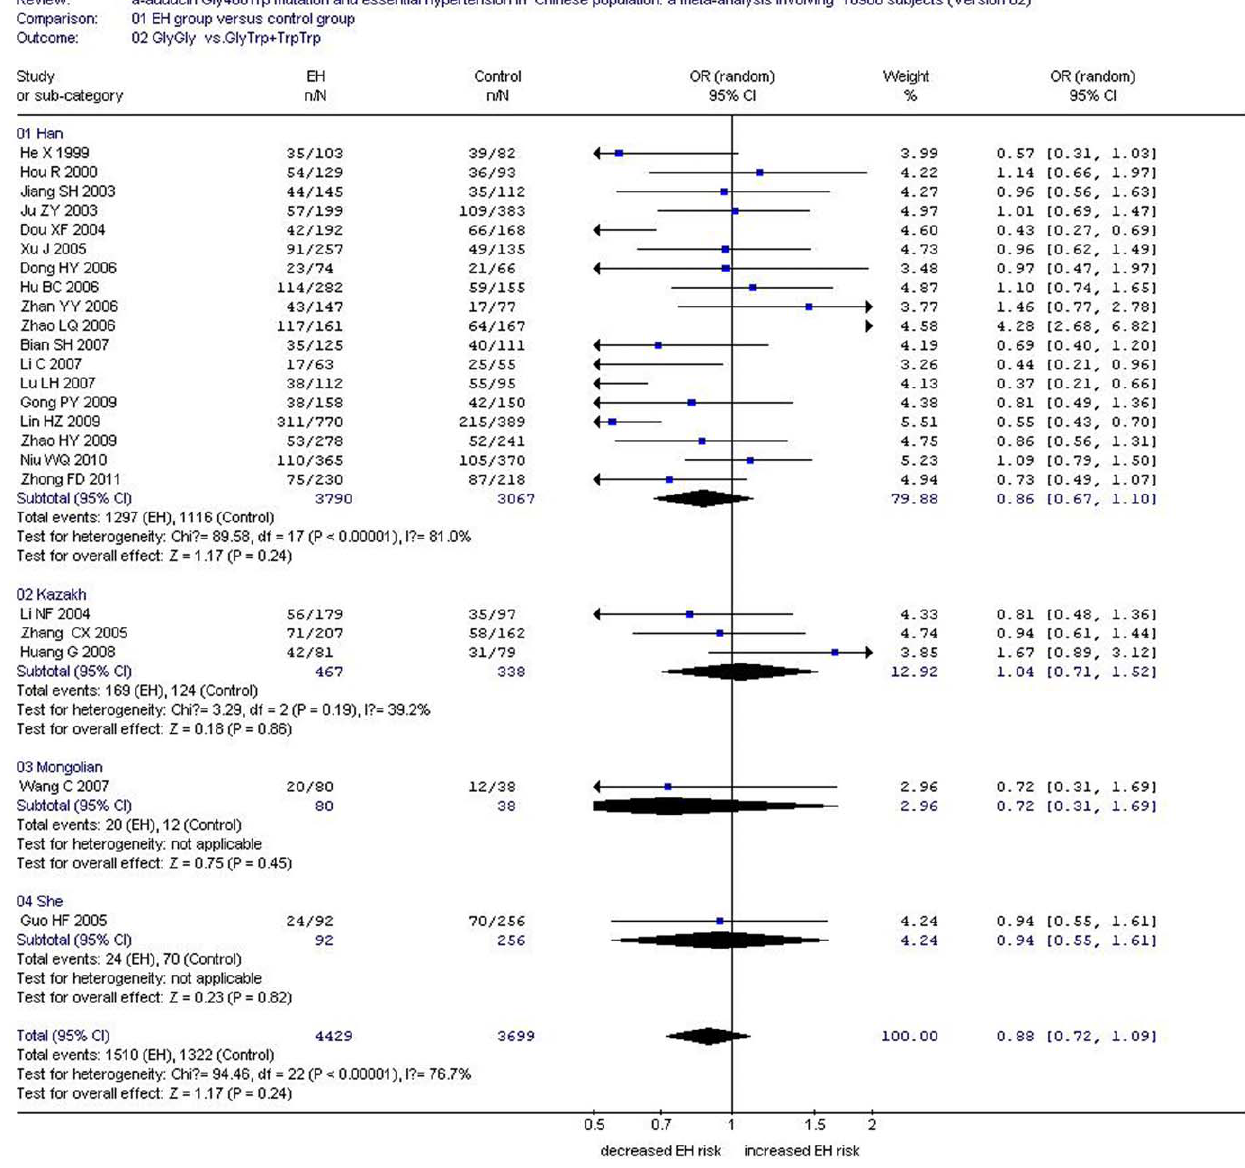
Figure 4. Forest plot of essential hypertension associated with a -adducin Gly460Trp gene polymorphism under a dominant genetic model (GlyGly vs. GlyTrp + TrpTrp) stratified by ethnicity.